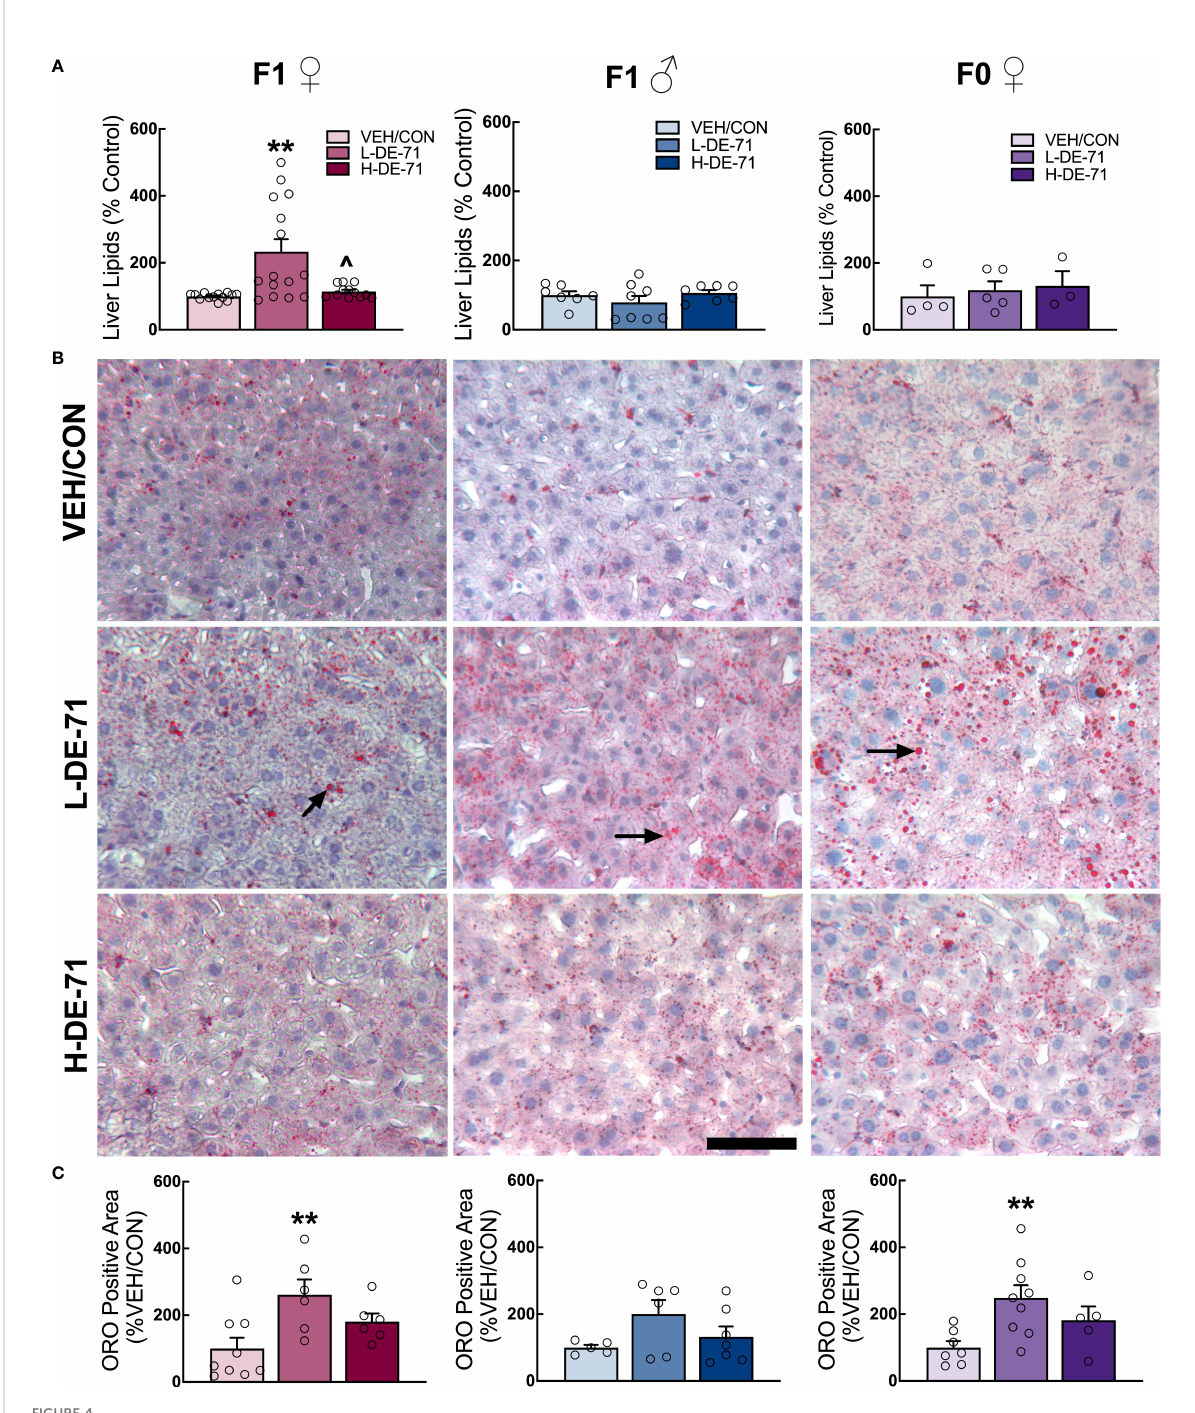
FIGURE 4 Sex-dependent effects of perinatal exposure to L-DE-71 on liver lipids in male and female offspring. (A) Total hepatic liver lipids expressed as percent VEH/CON. (B) Representative micrographs of liver samples processed for Oil Red O staining show lipid globules (black arrows) on hematoxylin stained hepatocytes. (C) Densitometric quanti fi cation in ORO-stained livers. **compared to VEH/CON , p <0.01. Bars and error bars represent mean±s.e.m. Sample size (n/group): (A) female offspring, 12-15; male offspring, 5-8; dams, 5-9. (C) female offspring, 6-9; male offspring, 5-6; dams, 4-8. Scale bar, 100